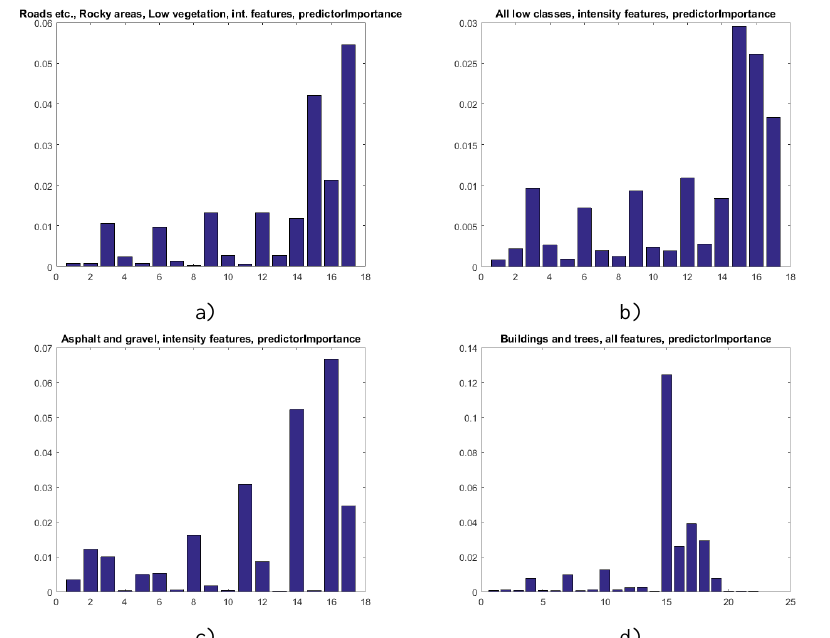
Figure 3. Importance of features (see Table 1) in separating different classes from each other. a) Roads etc. (class includes asphalt and gravel), rocky areas, and low vegetation. b) All low classes, i.e., asphalt, gravel, rocky areas, and low vegetation. c) Asphalt and gravel. d) Buildings and trees. Both intensity and DSM features (feature numbers 1–22) were tested case d), while only intensity features (feature numbers 1–17) were tested in the other cases.